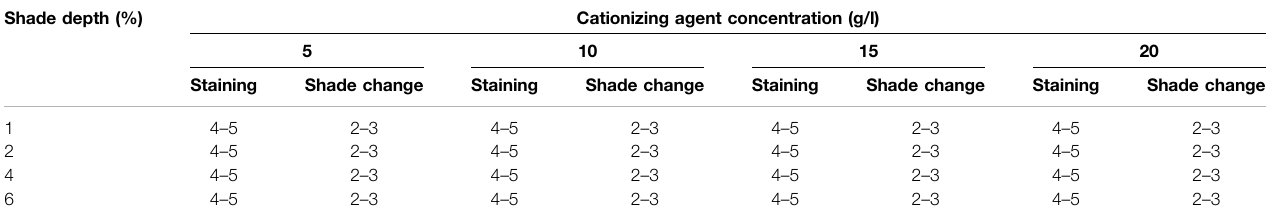
TABLE 2 | Colorfastness to washing results of cationized cotton dyed samples recorded by following the ISO 105-A05 standard protocol. Shade depth